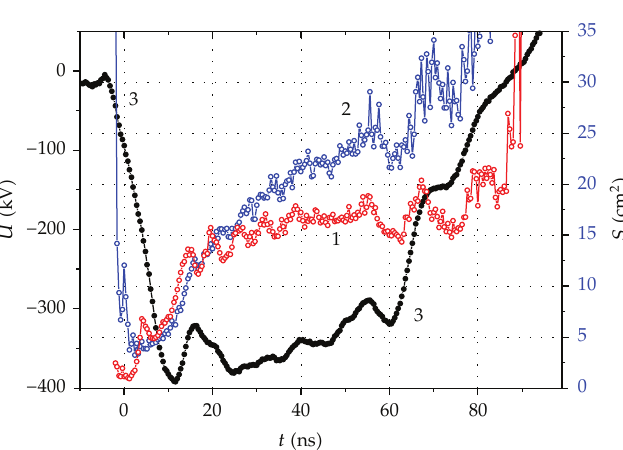
Figure 7: Change in cathode emitting surface during electron current generation, for cathodes of diameter (cid:2) 1 (cid:3) 45mm, S (cid:6) 16 cm 2 and (cid:2) 2 (cid:3) 60mm, S (cid:6) 28 cm 2 . (cid:2) 3 (cid:3) represents a waveform of voltage.